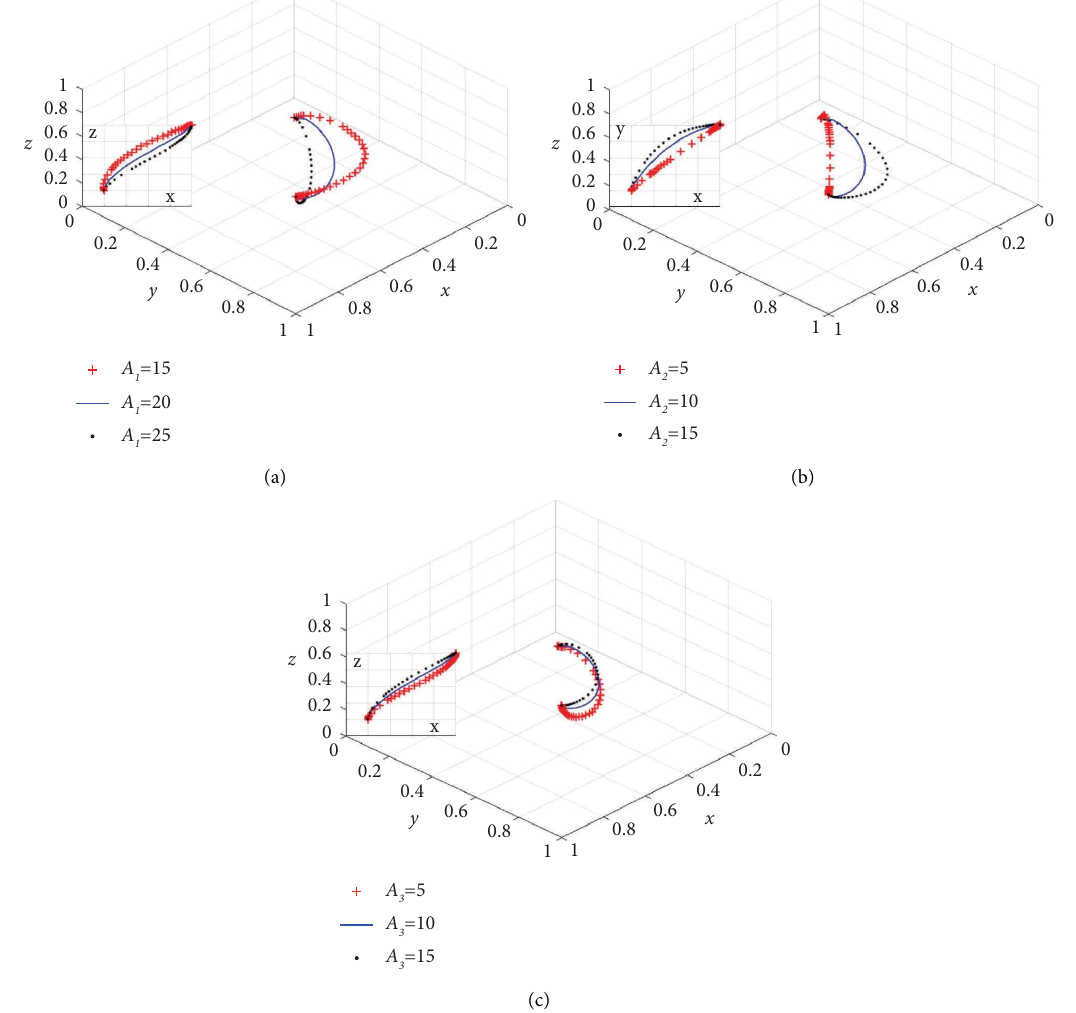
1 , (b) A 2 and (c) A 3